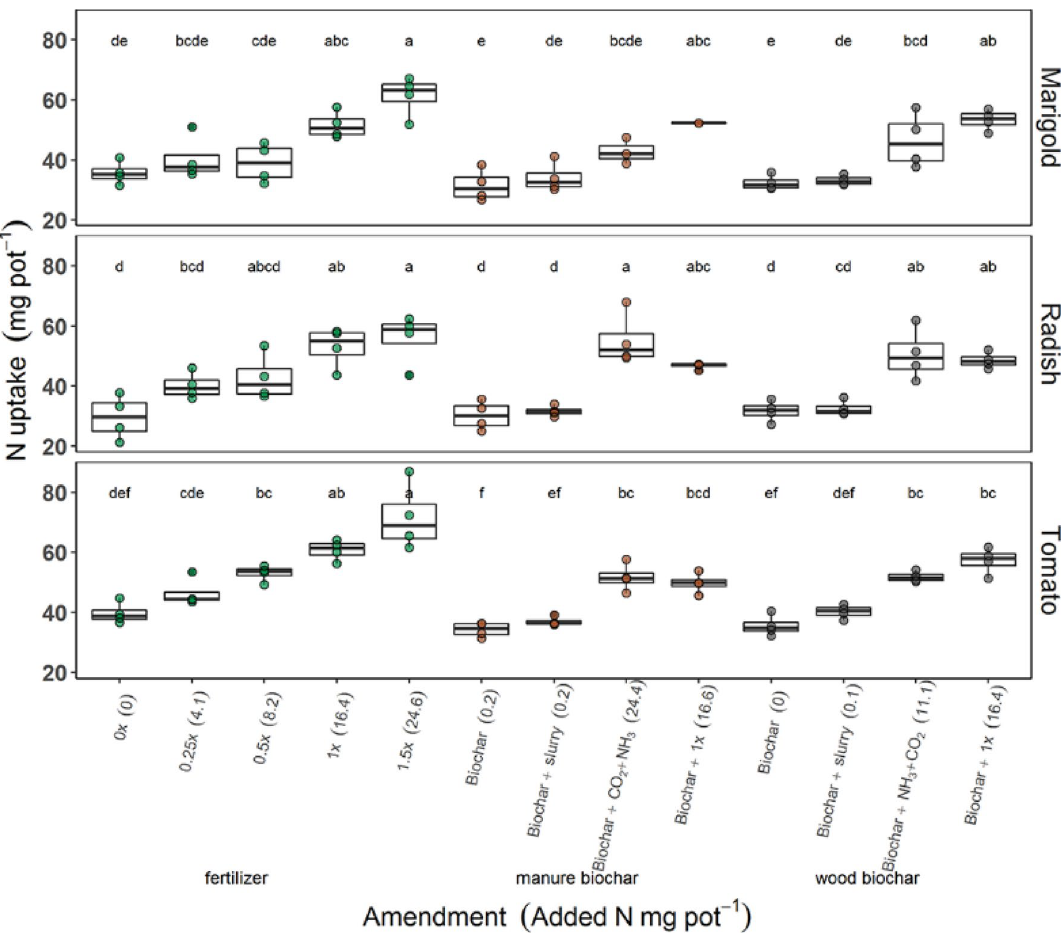
Figure 2. Total nitrogen uptake in shoot and root biomass of plants grown with urea fertilizer, manure biochar or wood biochar amendments or no amendments (0×). Letters above the bars indicate significant differences between amendments within plant type ( p < 0.05; n =